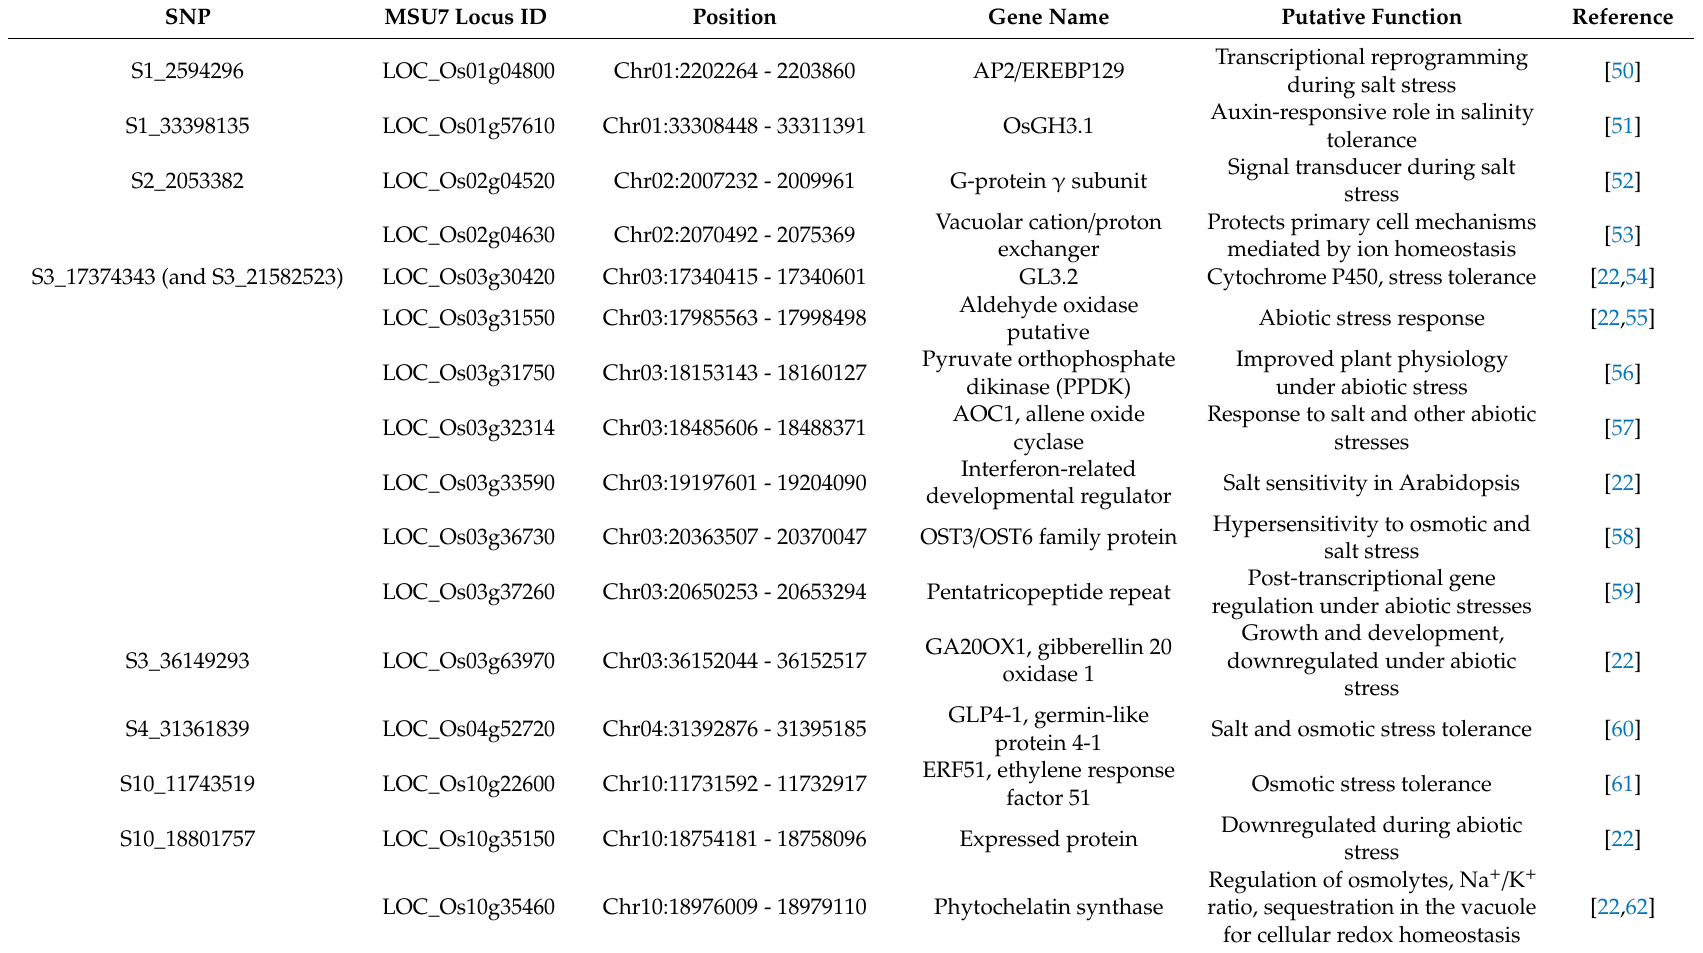
Table 4. Candidate genes in the chromosomal region of representative SNPs associated with salt stress tolerance at the seedling stage in